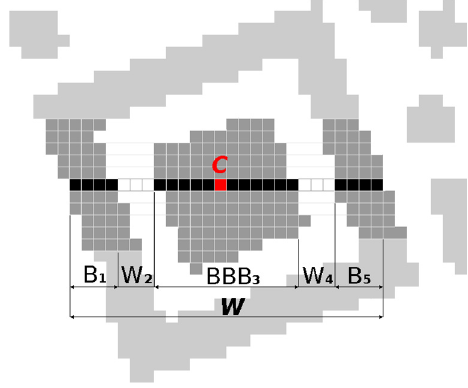
Figure 4. Finder pattern candidate matching 1:1:3:1:1.